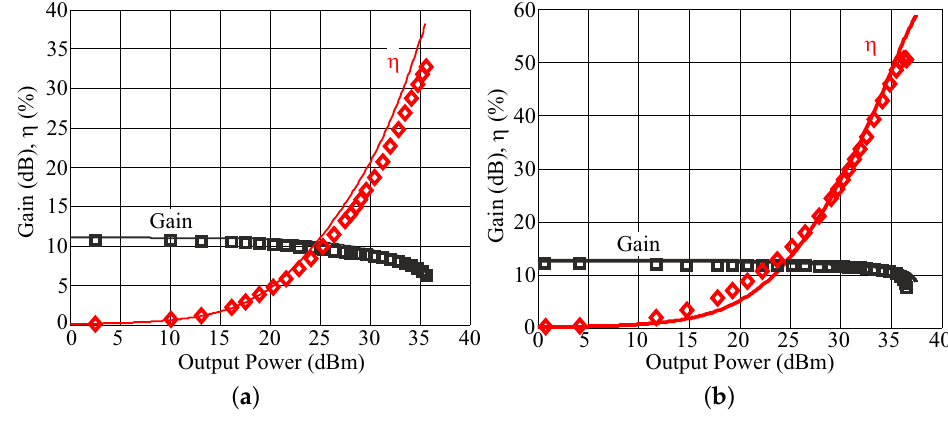
Figure 6. Measured power sweeps at 7 GHz of the Tuned Load ( a ) and Harmonic Tuned ( b ) PAs. Drain bias voltage is 30 V for both PAs. Drain bias current is 60 mA and 30 mA respectively. Simulations: solid lines; measurements: symbols. Gain: black squares, efficiency: red